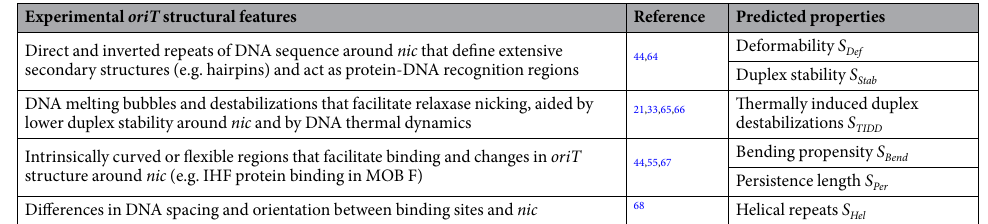
Table 1. oriT structural properties that enable relaxasome formation and nicking of DNA to initiate transfer of conjugative elements. Shown are experimentally determined oriT structural features and predicted structural properties that were used to interpret